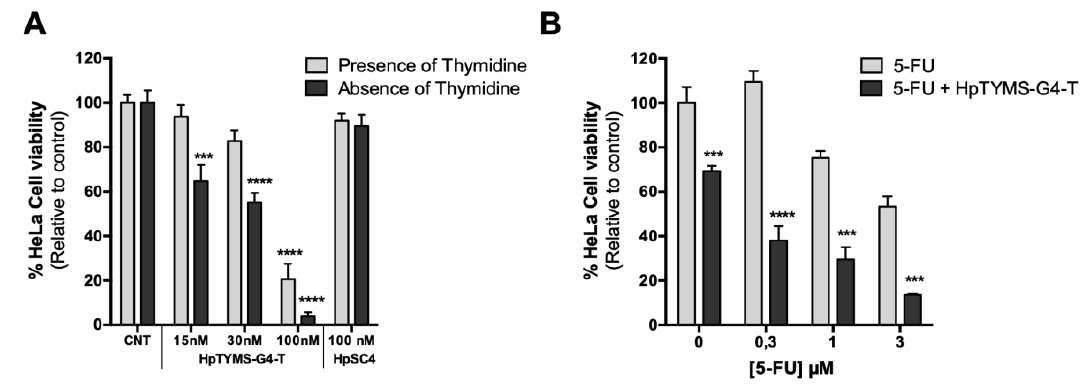
Figure 7. E ff ect on HeLa cell viability of HpTYMS-G4-T. ( A ) Dose–response of HeLa cell Figure 7. Effect on HeLa cell viability of HpTYMS-G4-T. (A) Dose – response of HeLa cell viability